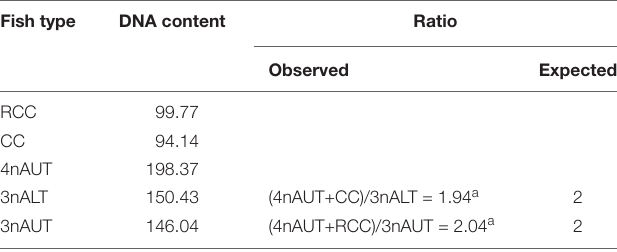
TABLE 4 | Mean DNA content of 3nAUT, 3nALT and their